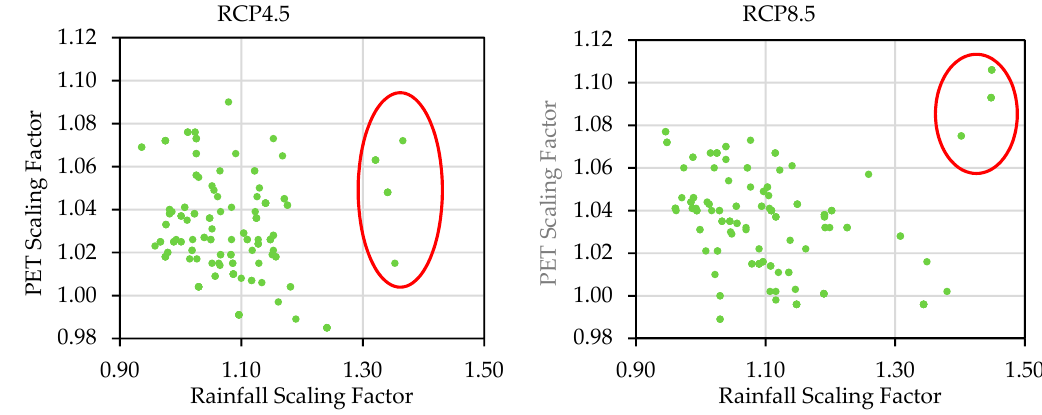
Figure 6. Scatter plot of modelled scaling factors for rainfall and PET for 28 GCMs for the six GCM grids. Red circles show the outliers in model projections.